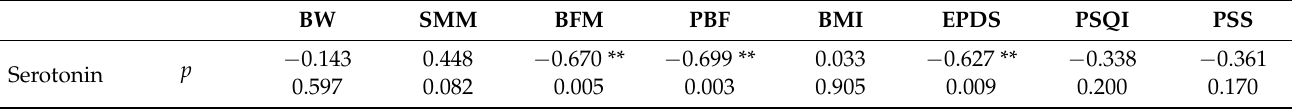
Table 6. Correlations between body composition and psychological effects and